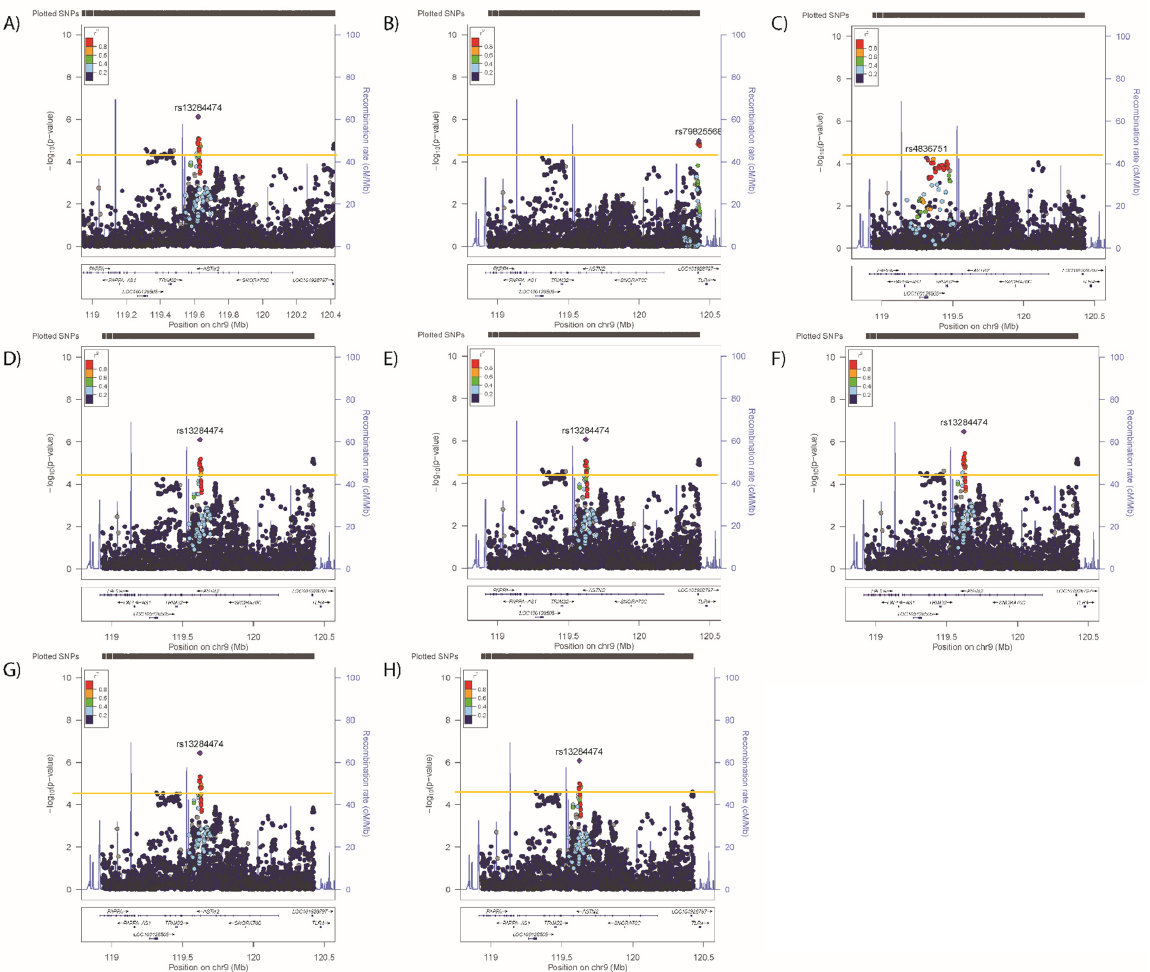
Figure 8. Results of associations between ASTN2 and ( A ) mood instability, adjusted for the primary SNP for ( B ) mood instability, ( C ) primary and secondary SNPs for mood instability, ( D ) primary SNP for SBP/DBP, ( E ) BMI, ( F ) WHRadjBMI, ( G ) neuroticism and ( H ) anhedonia. Significance was set at p -value < 5.45 × 10 − 5 or − log10 > 4.26 (Horizontal yellow line). LD (r2) with the lead SNP are indicated by colour. Grey indicates that there is no LD information available.